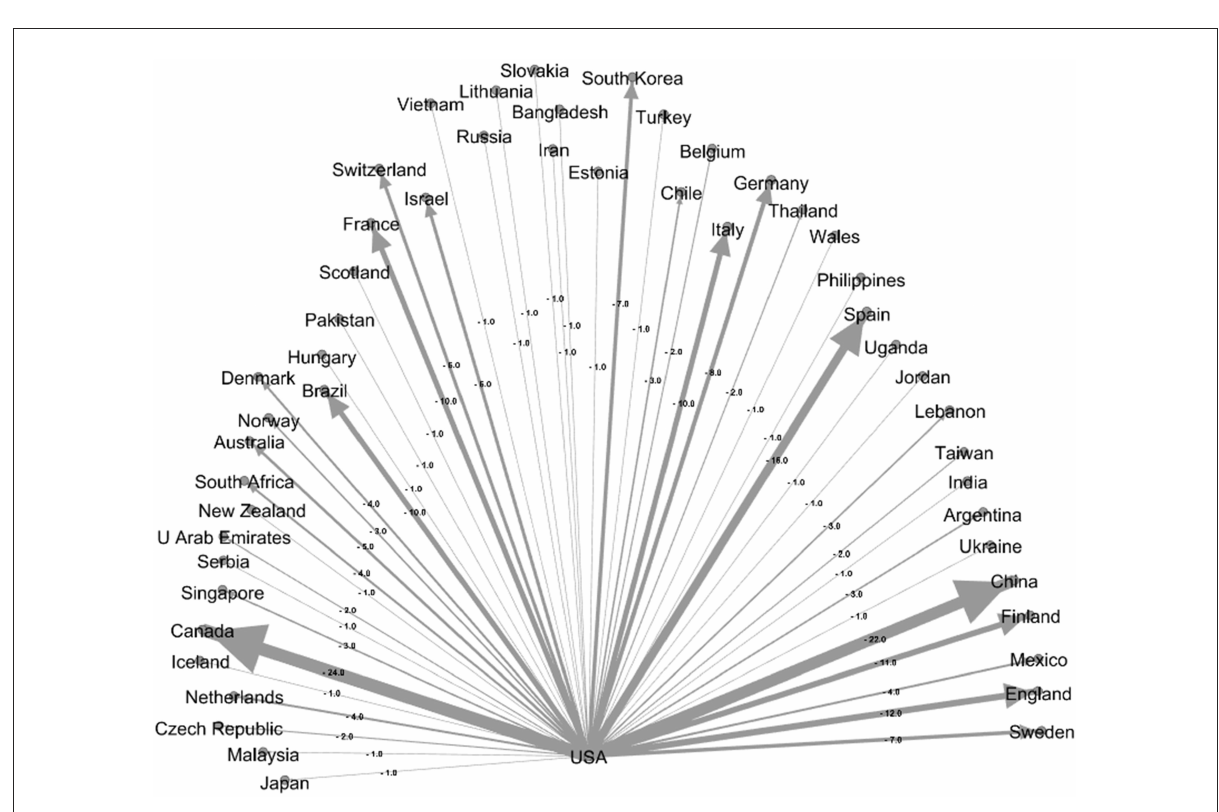
FIGURE6 US cooperation network with other